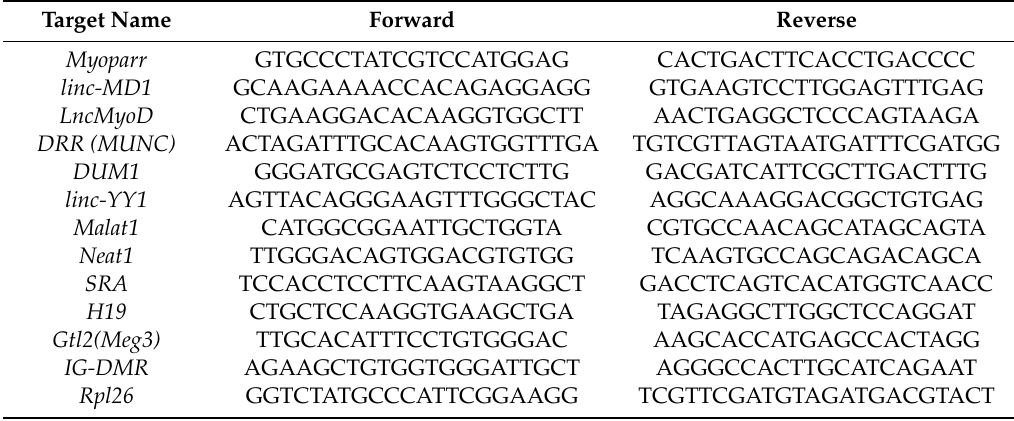
Table 2. Primer sequences used for quantitative